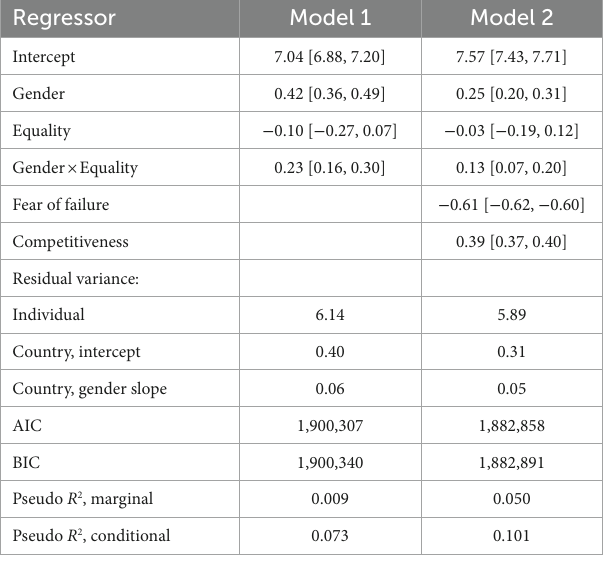
TABLE 4 Results of mixed-level analyses of life